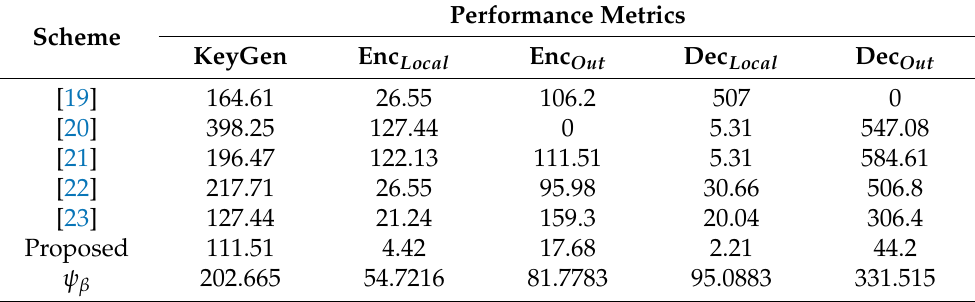
Table 7. Cross-efficient